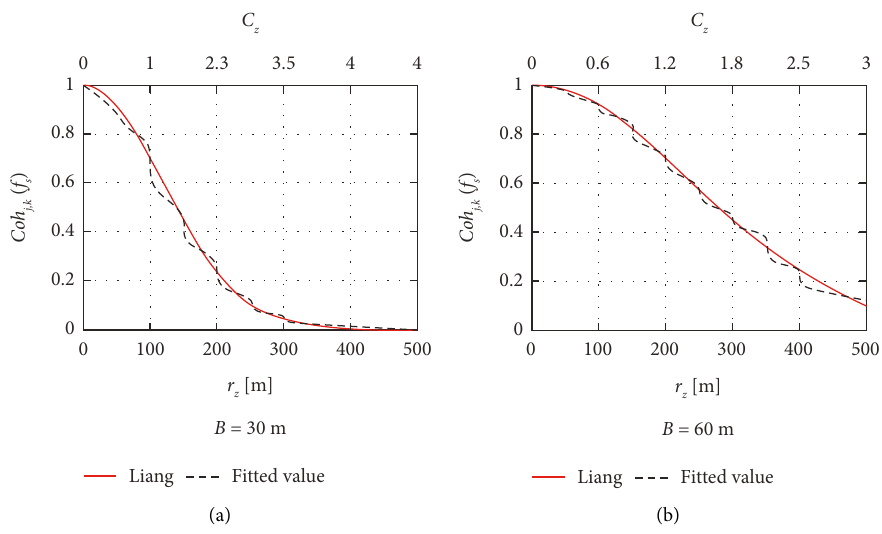
Figure 4: Vertical correlation at vortex shedding frequency for across-wind forces: D/B �